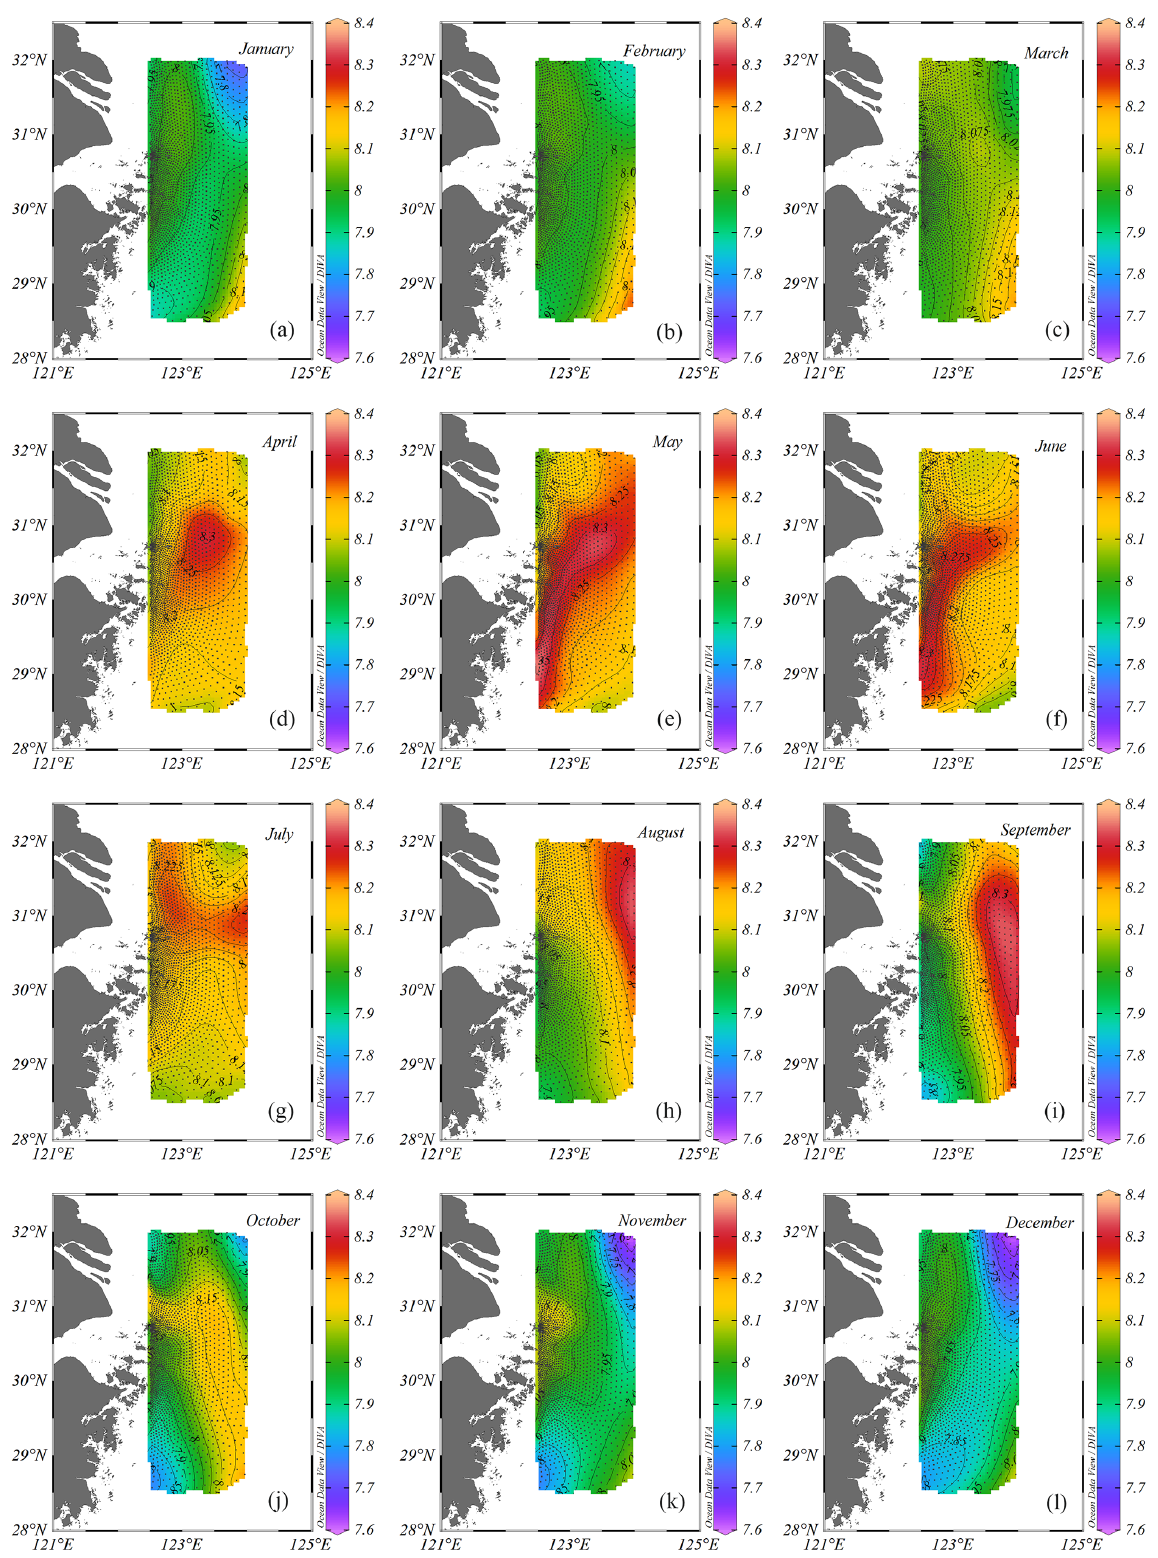
Figure 13. Spatial distribution of monthly average surface pH T retrieved by the ANN model using Changjiang biology FVCOM output. (a) January; (b) February; (c) March; (d) April; (e) May; (f) June; (g) July; (h) August; (i) September; (j) October; (k) November; (l) De-